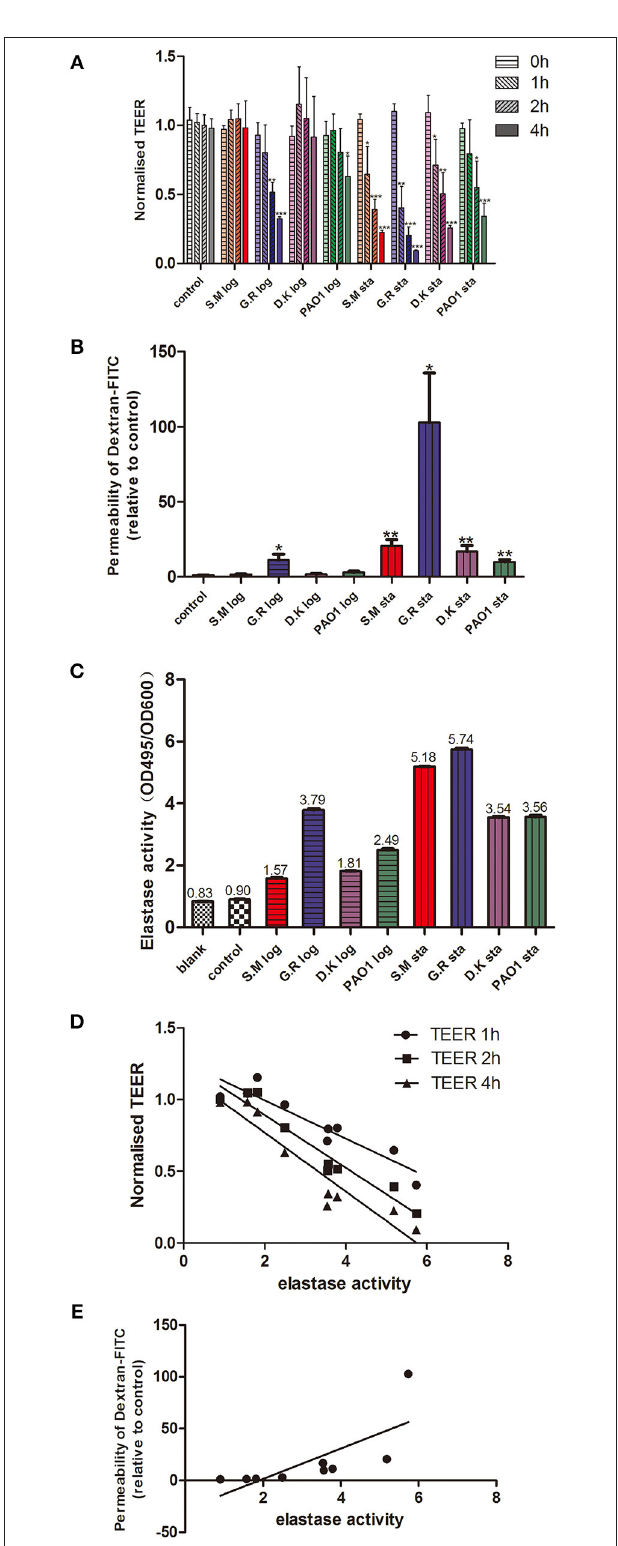
FIGURE 1 | P. aeruginosa exoproteins cause mucosal barrier dysfunction in correlation with elastase activity. P. aeruginosa exoproteins collected from 3